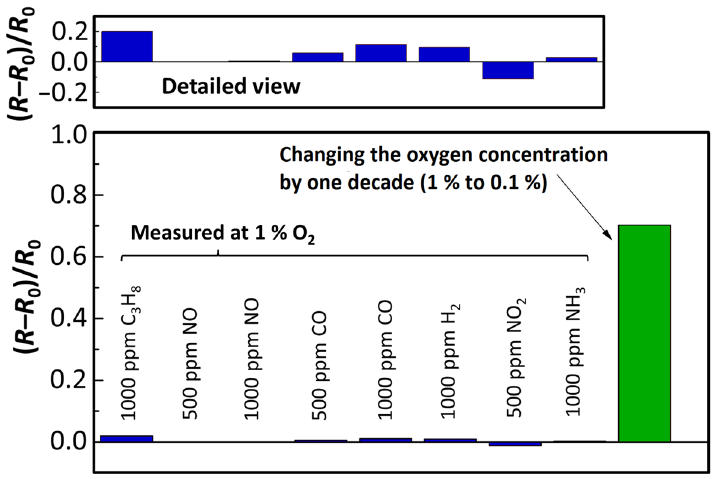
Figure 9. Comparison of cross-sensitivities to different gaseous pollutants measured at an oxygen concentration of 1% (Sensor B data).